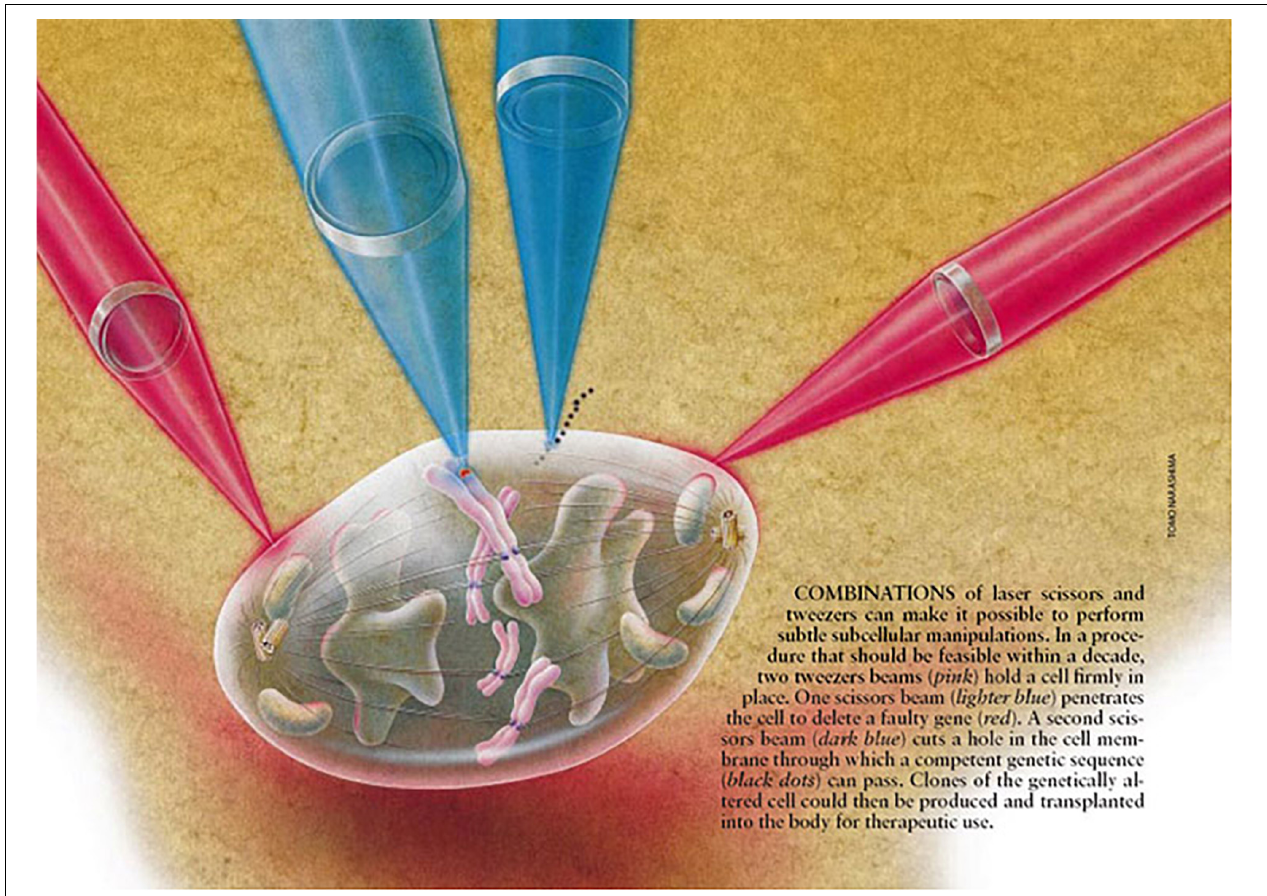
FIGURE 10 | Laser scissors and tweezers conceptional schematic illustrating optical manipulation of a chromosome in a diviiding mitotic cell (after Berns,